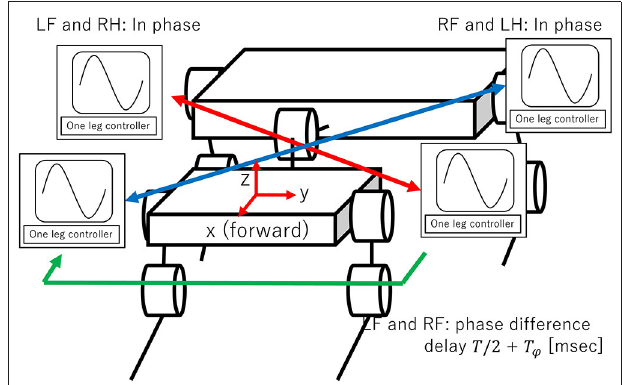
FIGURE 5 | Proposed interlimb controller. The phase difference is set as follows: LF and RH controllers and RF and LH controllers are in phase. Phase difference between two diagonal pairs (LF and RH controllers and RF and LH controllers) can be changed by varying T φ .